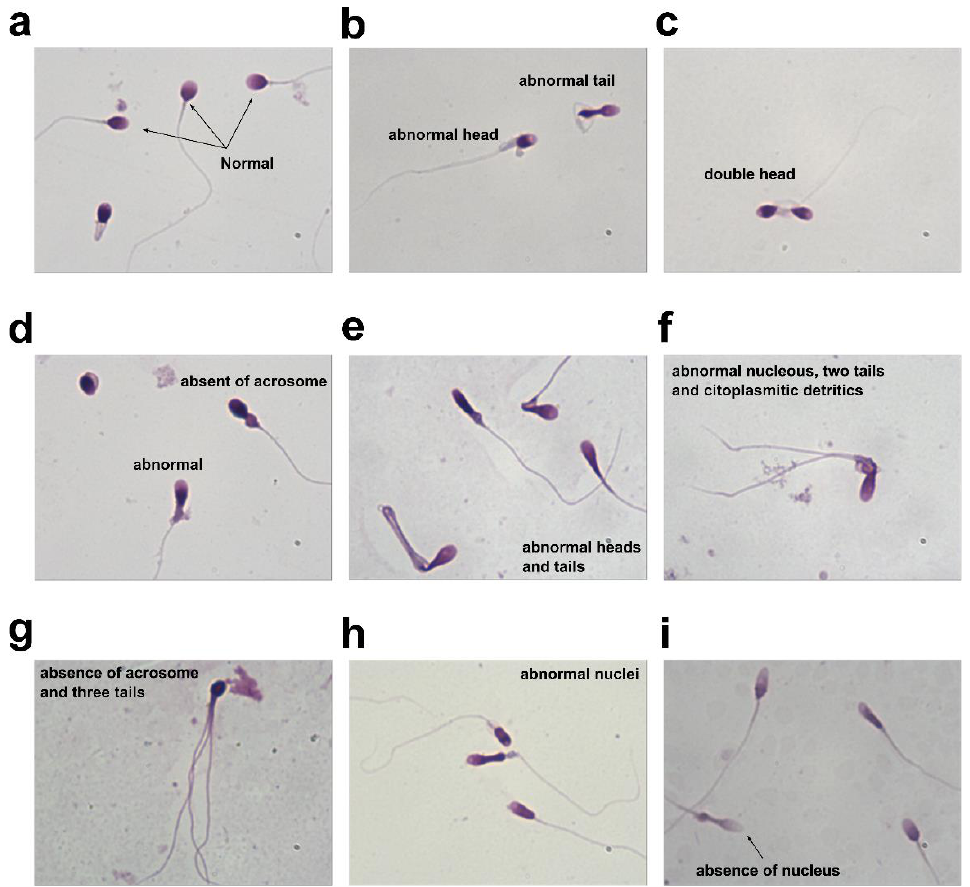
Figure 5. Diff-quick staining of VSR group ’s spermatozoa. ( a ): control group; ( b – i ): VSR group.